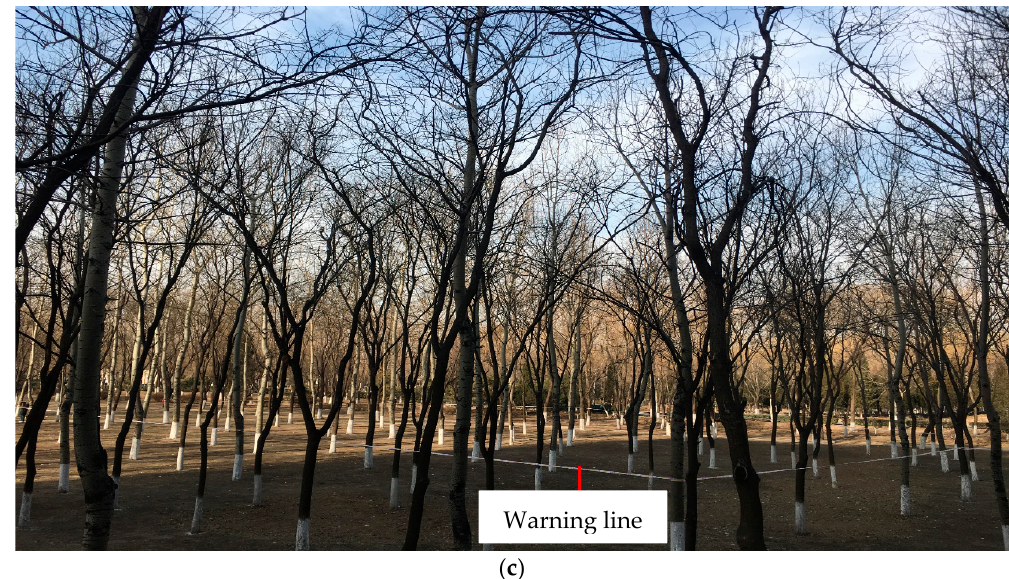
Figure 2. Experimental area. ( a ) Geographical location; ( b ) schematic representation; ( c ) experimental setup.